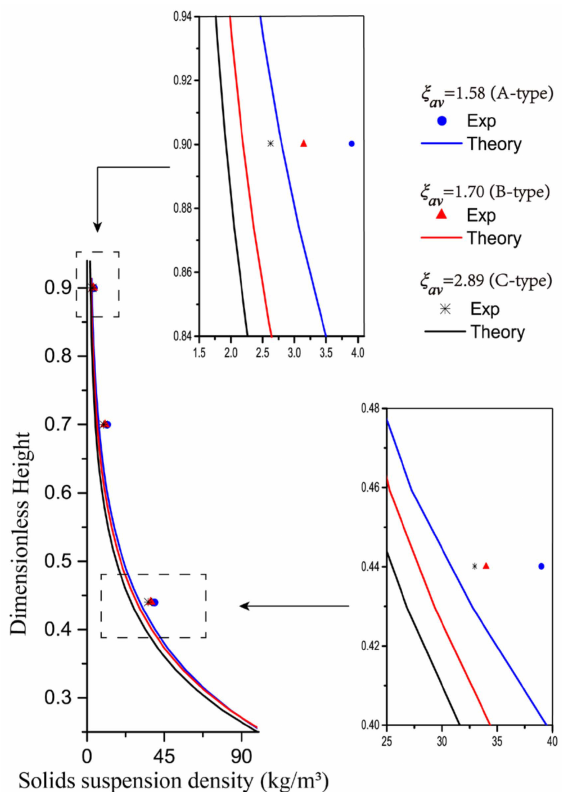
Figure 7. Axial gas-solid suspension density profile at different connection